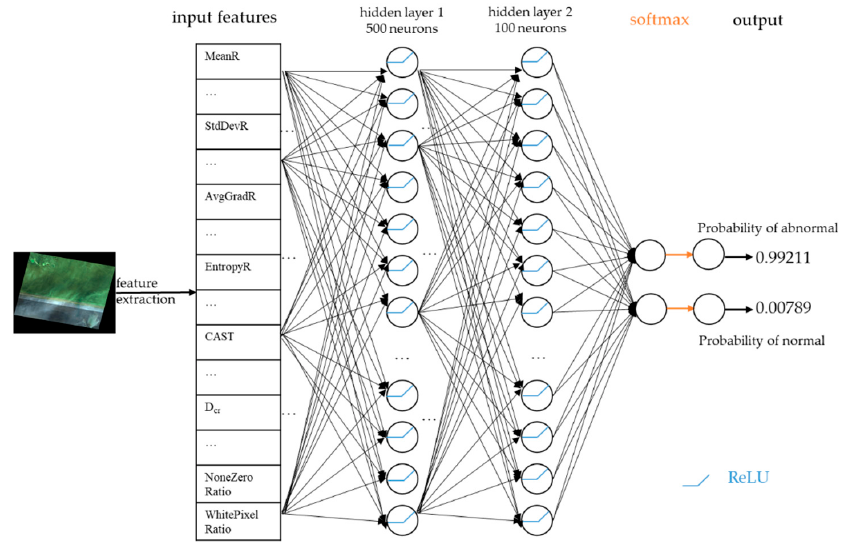
Figure 3. Architecture of our ANN model.